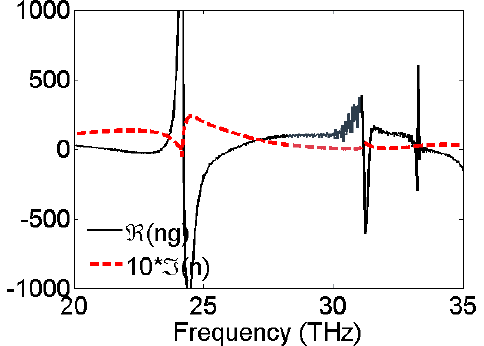
Figure 3. Group index and imaginary part of the effective index of the MSRR structure without substrate. Shaded area shows the domain of